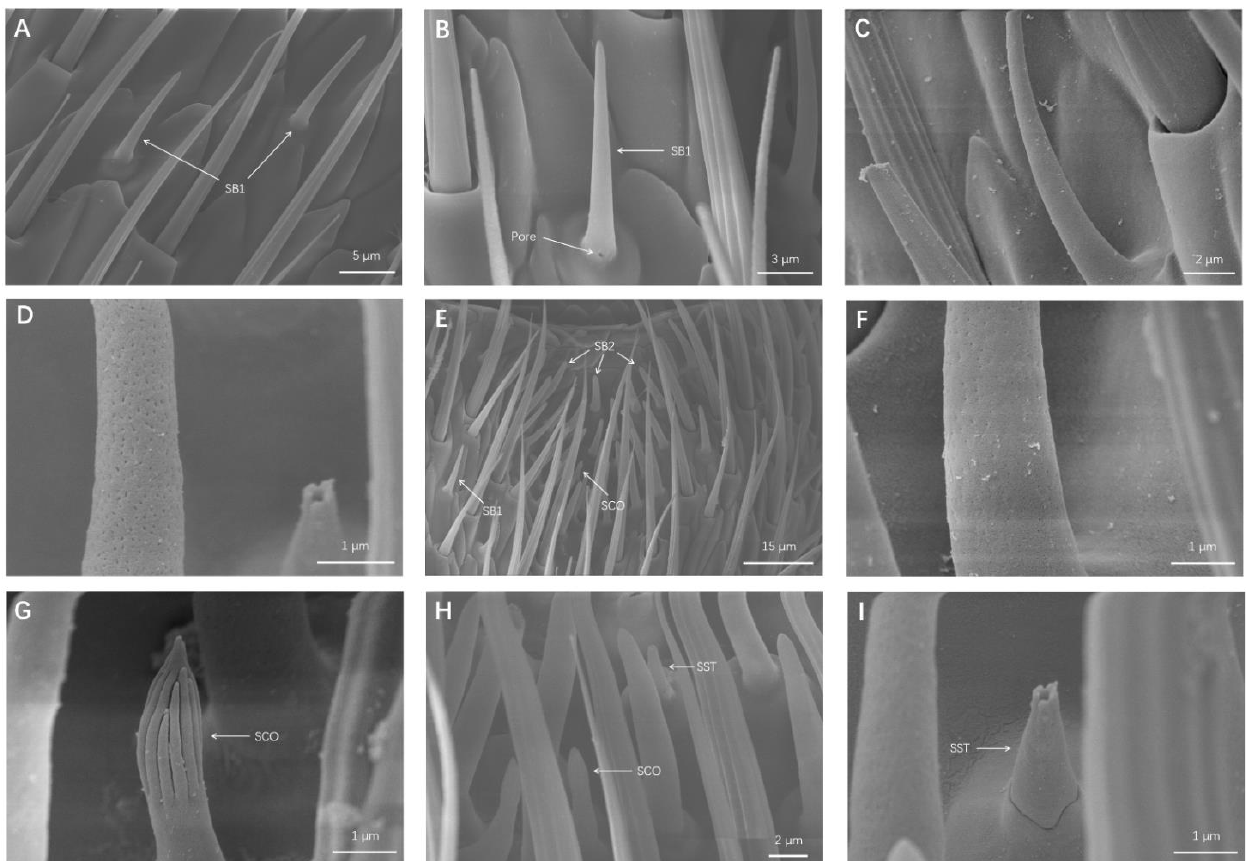
Figure 3. Details of sensilla basiconica (SB), sensilla coeloconica (SCO), and sensilla styloconica (SST). ( A ) SB1 distributed on a flagellomere. ( B ) A few SB1 that have a small pore on the bottom pedestal. ( C ) Magnification of SB1. ( D ) Magnification of small pores on the wall of SB1. ( E ) SB2 centrally distributed on the top section of flagellomeres 4–9, and SCO located in a SB2 densely distributed area. ( F ) Magnification of small pores on wall of SB2. ( G ) Magnification of SCO. ( H ) SST located next to SCO in a SB2 densely distributed area. ( I ) Magnification of